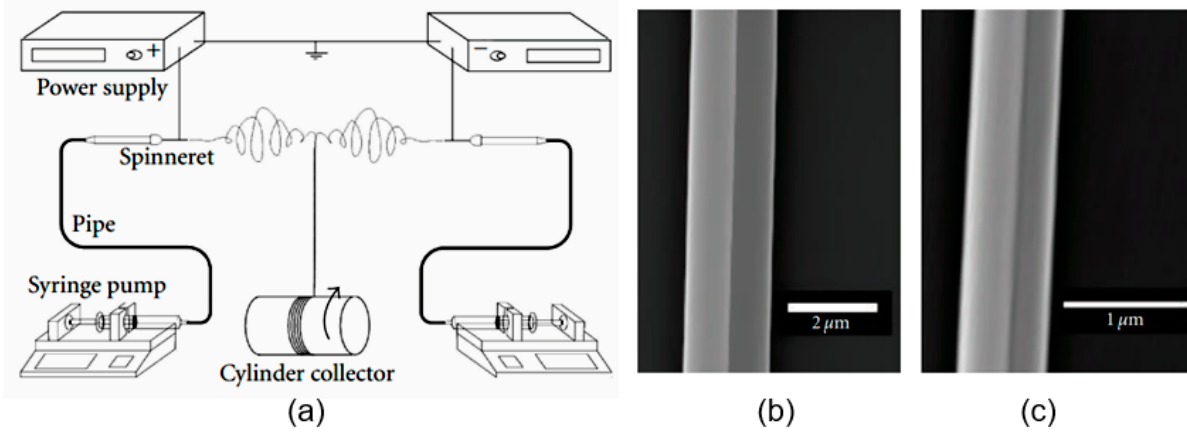
Figure 9. ( a ) Schematic diagram of dual-opposite-spinneret electrospinning apparatus. ( b , c ) Detailed microstructure of side-by-side fiber by FE-SEM ( b ) as-electrospun composite fiber and ( c ) calcined TiO 2 –SnO 2 nanofiber. Reprinted from [135].